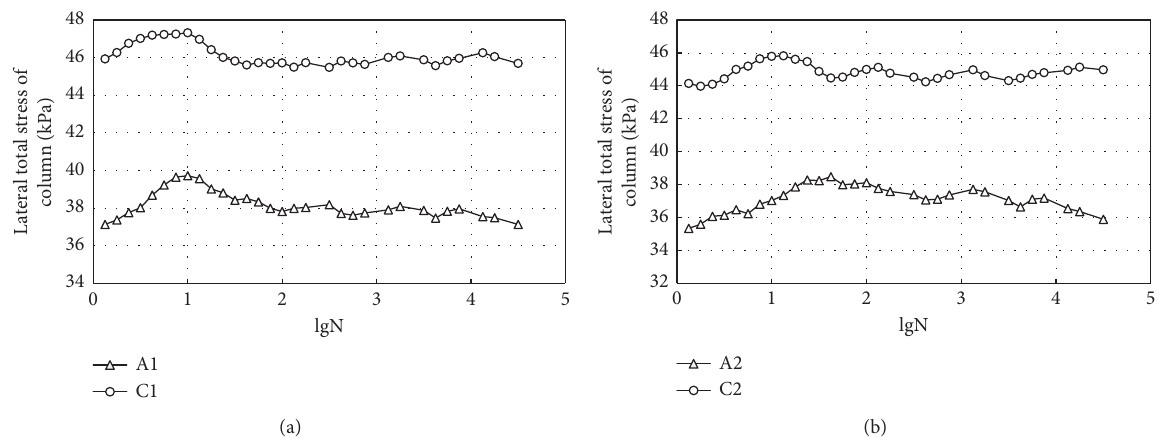
Figure 10: Lateral total stress of the column: (a) single column; (b) single column composite